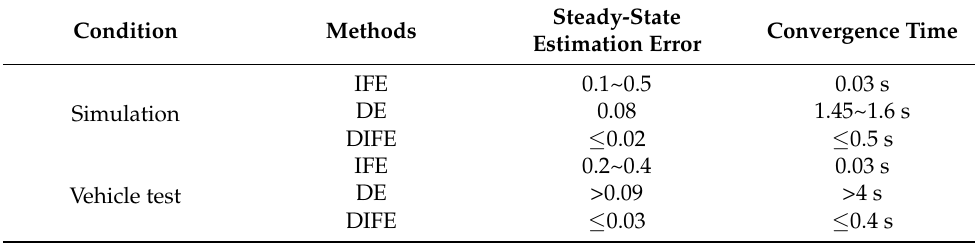
Table 5. Specific Test results of DIFE.